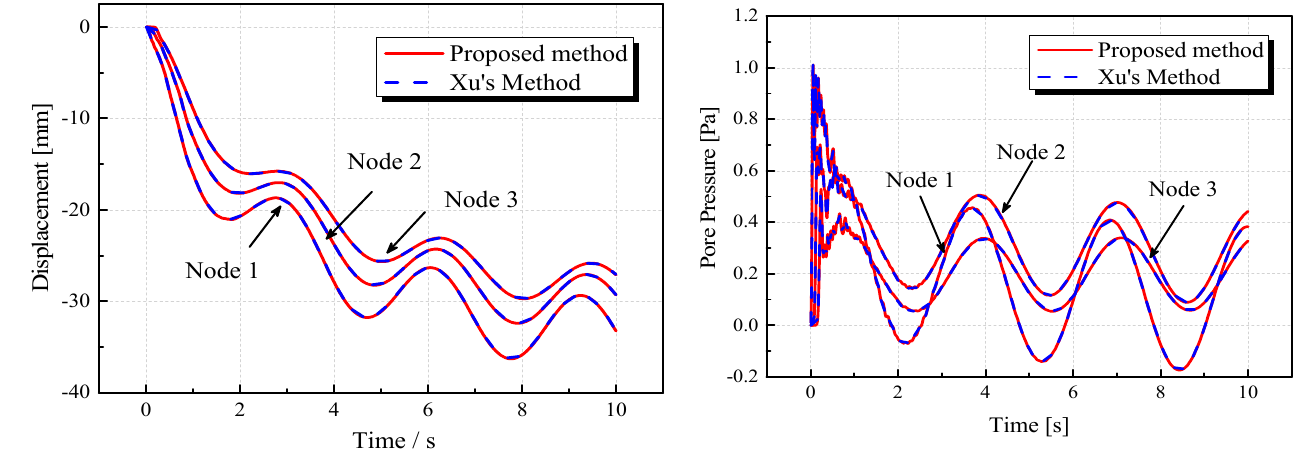
Figure 6. Dynamic responses of the 2D model for saturated porous media.